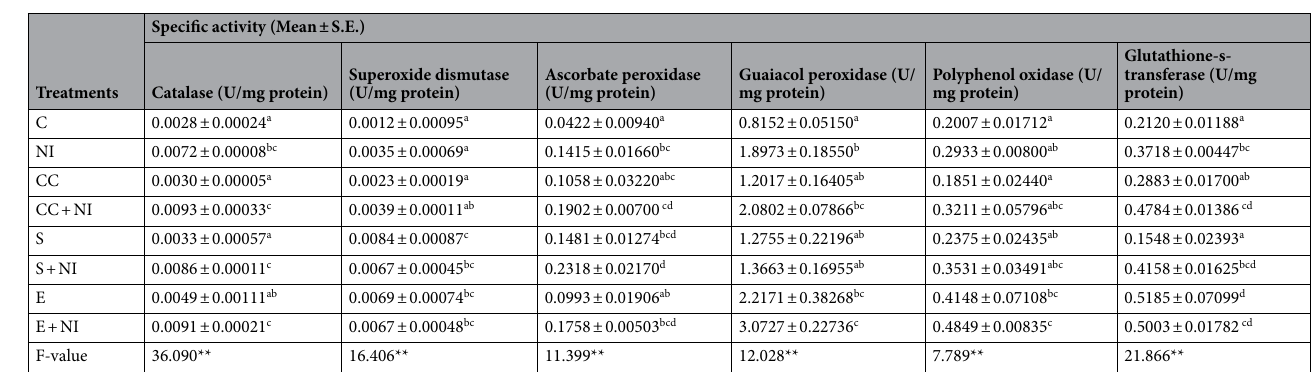
Table 2. Specific activities of antioxidative enzymes in M. incognita inoculated 60 days old tomato plants treated with S. hydrogenans strain DH-16. Different treatments are represented as C (control), NI (nematode inoculated), CC (culture cells), CC + NI (culture cells + nematode inoculated), S (supernatant), S + NI (supernatant + nematode inoculated), E (crude extract), E + NI (crude extract + nematode inoculated). Results are given in mean ± standard error and F-value ** indicates significance at p ≤ 0.01 as per Tukey’s test. Different letters a, b, c, d represent significant difference among treatments and same letters represent no significant